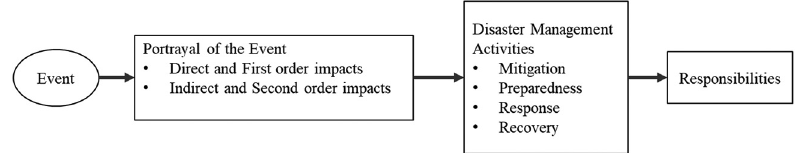
Figure 1. Representation